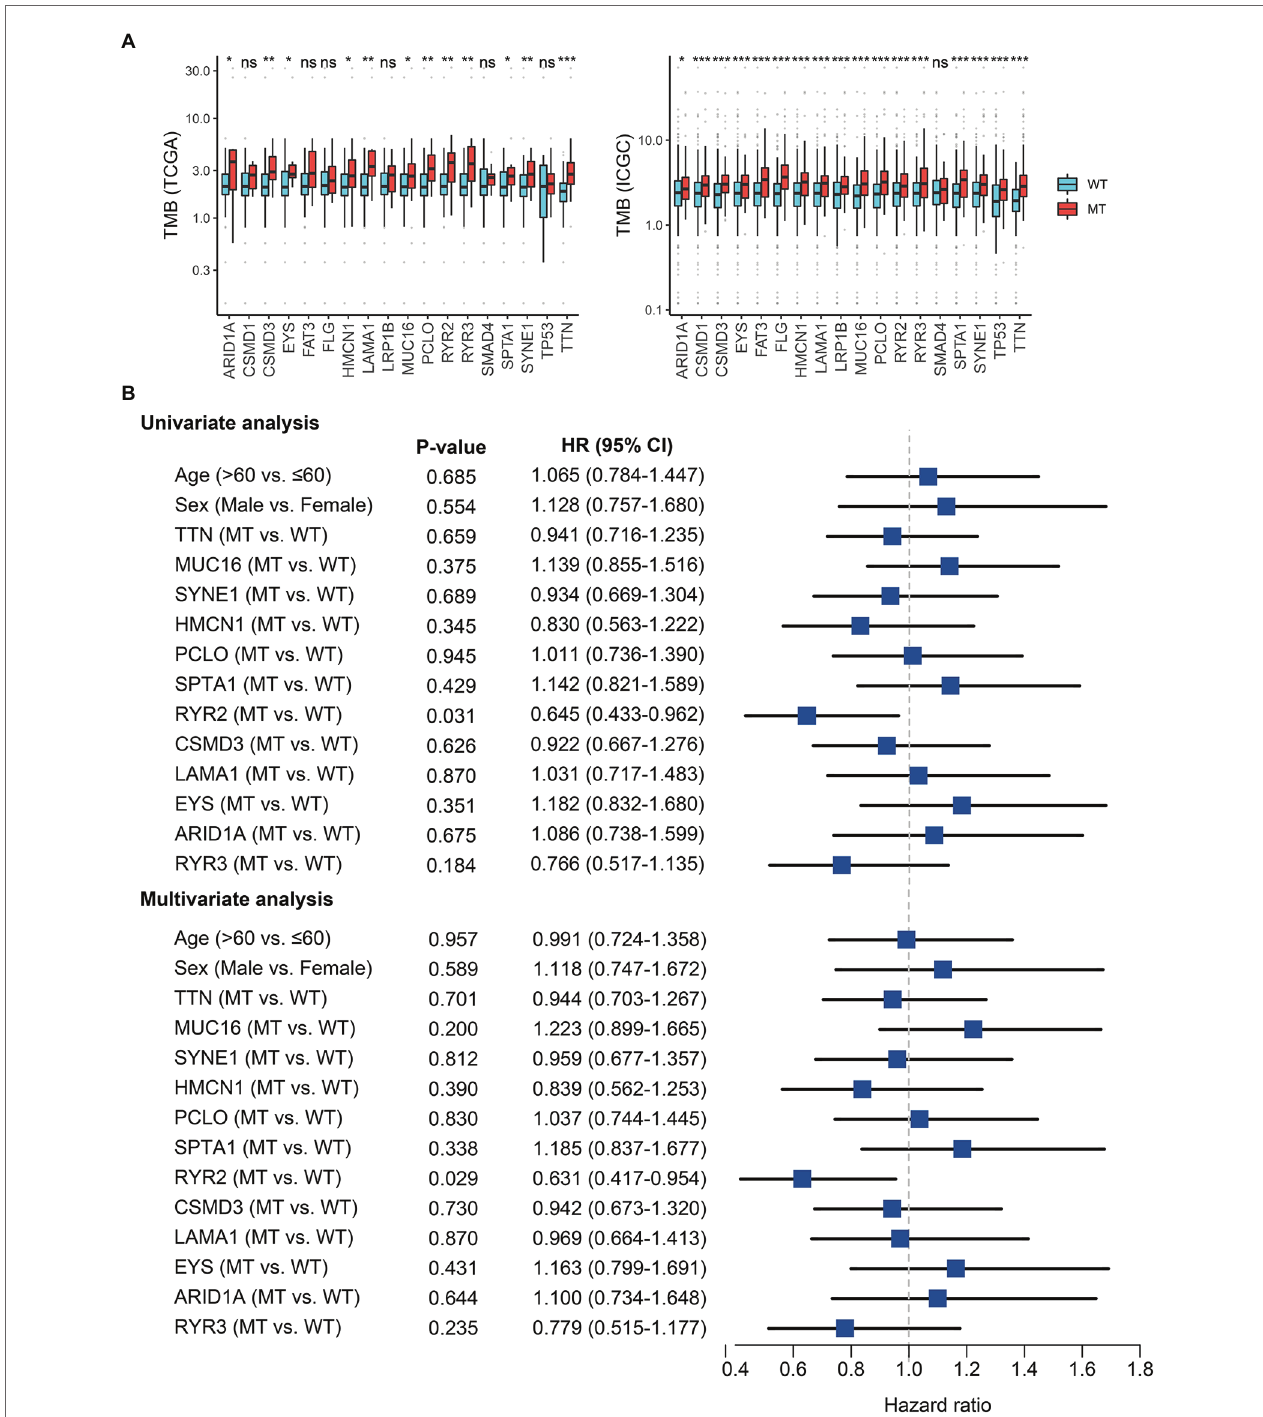
FIGURE 2 | RYR2 mutation was associated with tumor mutation burden (TMB) and clinical prognosis. (A) Most gene mutations are associated with a higher TMB. ns, p ≥ 0.05; * p < 0.05; ** p < 0.01; *** p < 0.001. (B) Univariate and multivariate Cox regression analysis. WT, wild type and MT, mutant